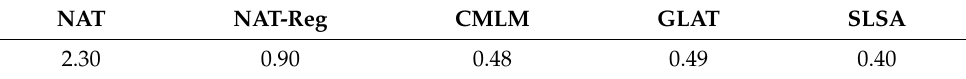
Table 2. The average repetitive tokens on the validation set of the DE → EN task.